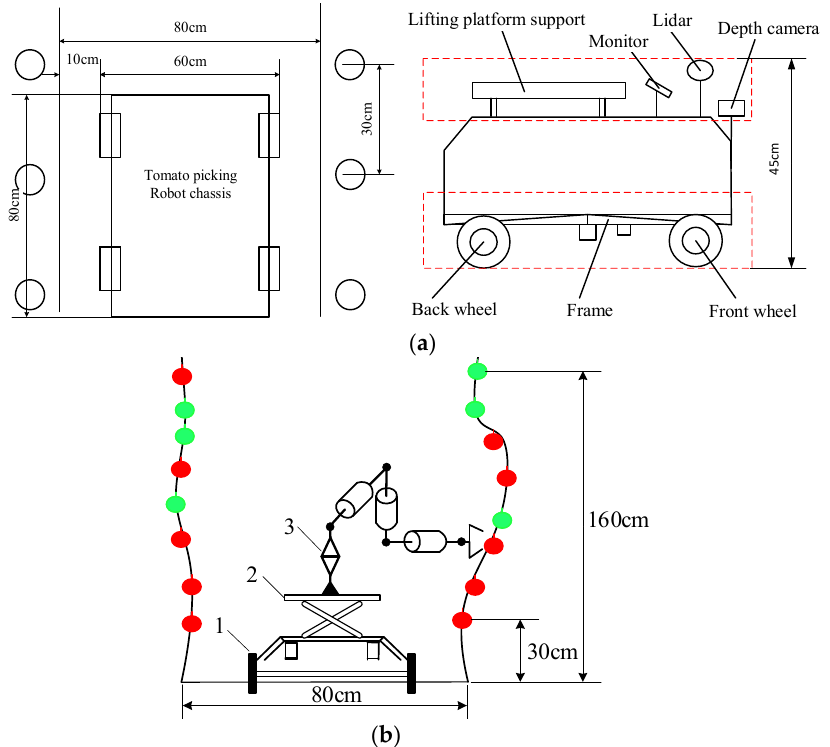
Figure 1. Schematic diagram of tomato planting mode.